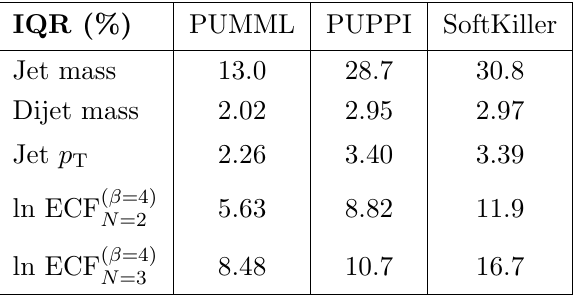
Table 2 . The interquartile ranges (IQR) of the distributions in (cid:12)gure 5. Note that PUMML performs better than either PUPPI or SoftKiller. Lower IQR indicates better